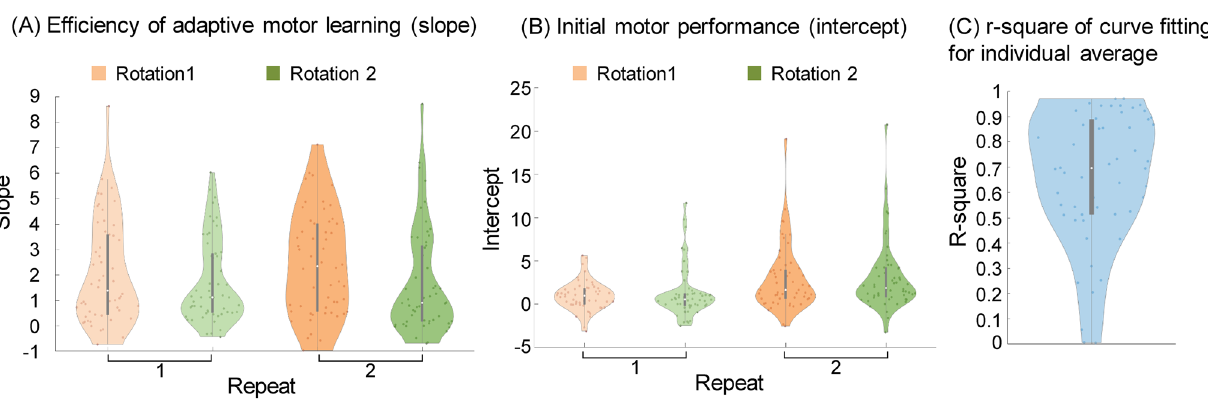
Figure 4. The plots of participants’ slope ( A ) and intercept ( B ) of log-linear regression in each condition; ( C ) the plot of r-square of curve fitting for the individuals’ averages of four